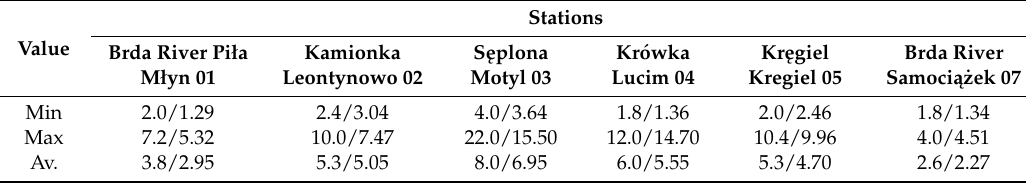
Table 2. Characteristic values of total suspended material (mg L − 1 ) and turbidity (FNU) for inflows and the outflow of Koronowski Reservoir in the hydrological year